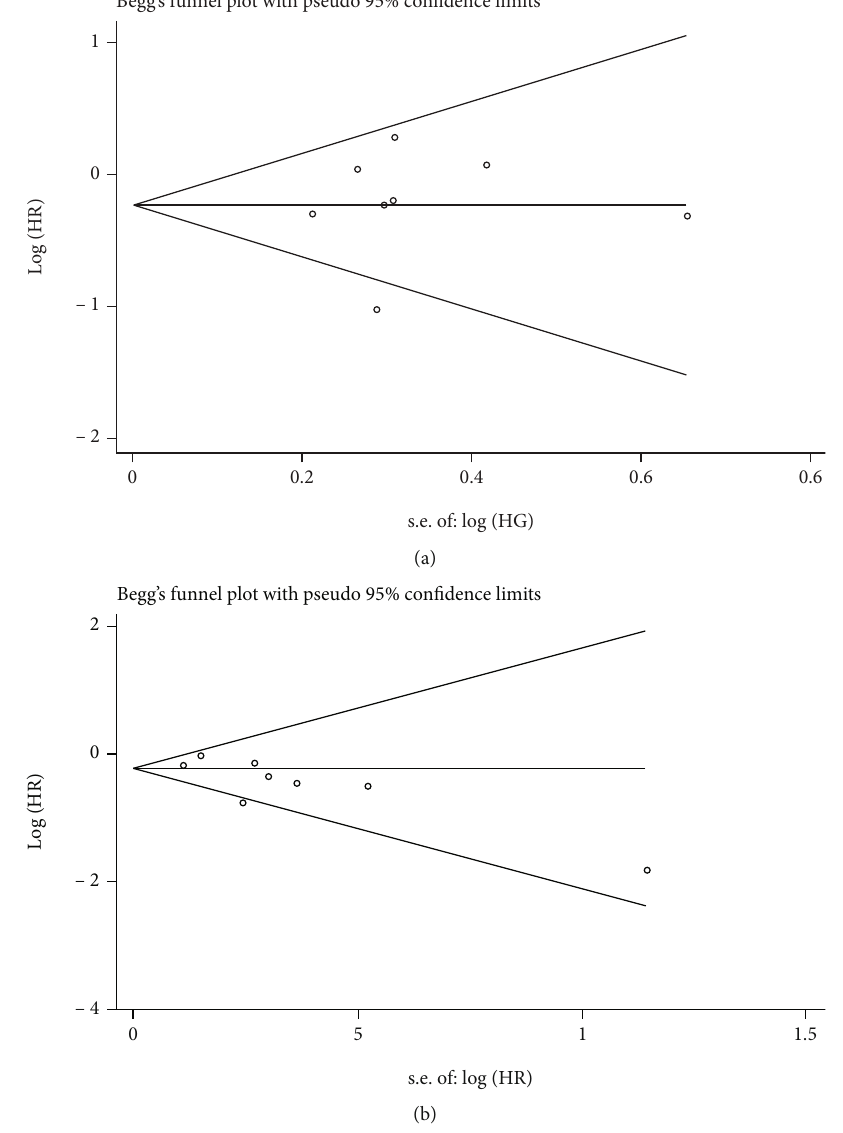
Figure 11: Funnel plots assessing the publication bias using Begg ’ s rank correlation test. (a) OS and